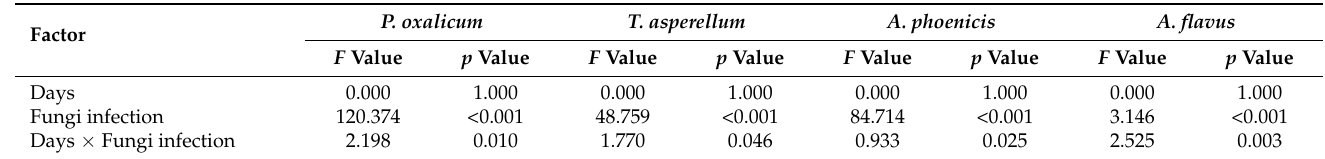
Table 1. Effects of fungi infection, days of YPM oviposition, and their interactions on the oviposition selection rates among different treatments by repeated-measures